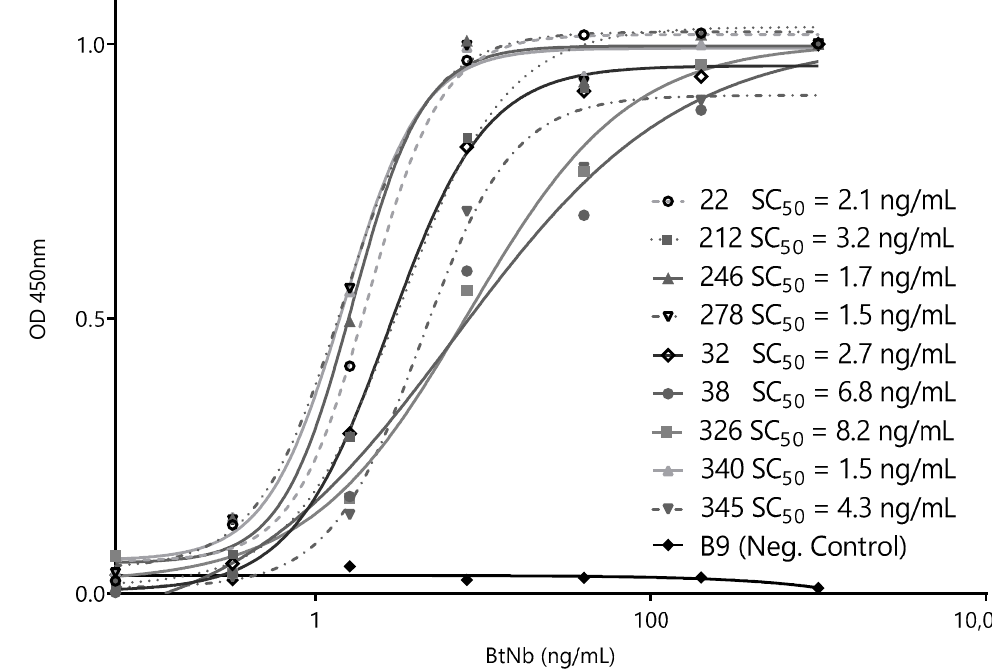
Figure 3. Titration curves of the selected capture nanobodies. Decreasing concentrations of each nanobody were exposed to a fixed concentration of ZVNS1 (100 ng / well) directly adsorbed on the ELISA well. Measurements were done by triplicates. SC 50 : 50% signal saturation and BtNb: biotinylated